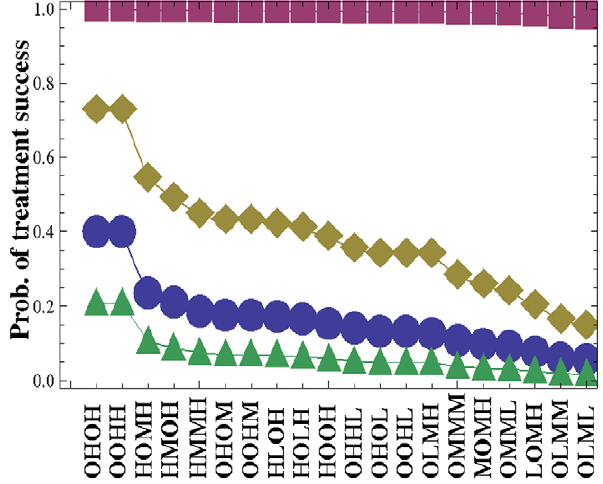
Figure 3. The ordered set of the best treatment protocols resulting from a application of Algorithm A2. The probability